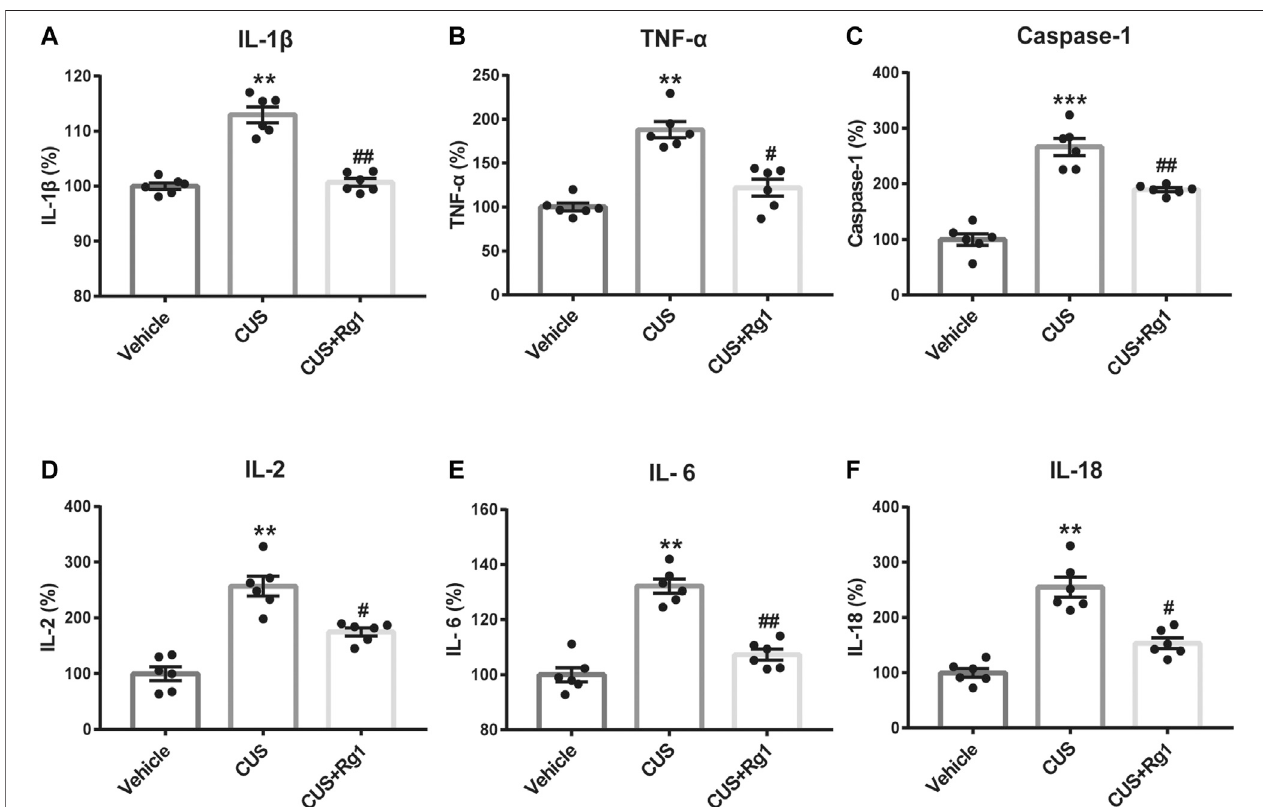
FIGURE 3 | Rg1 ameliorates evaluated in fl ammatory responses in serum of CUS rats. Treatment with Rg1 decreased the excessive secretion of IL-1 β (A) , TNF- α (B) , caspase-1 (C) , IL-2 (D) , IL-6 (E) ,and IL-18 (F) causedby CUS exposure. n (cid:1) 6per group. ** p < 0.01 and *** p < 0.001, compared withthe vehicle group; ## p < 0.01 and # p < 0.05, compared with the CUS group. IL, interleukin; TNF, tumor necrosis factor.